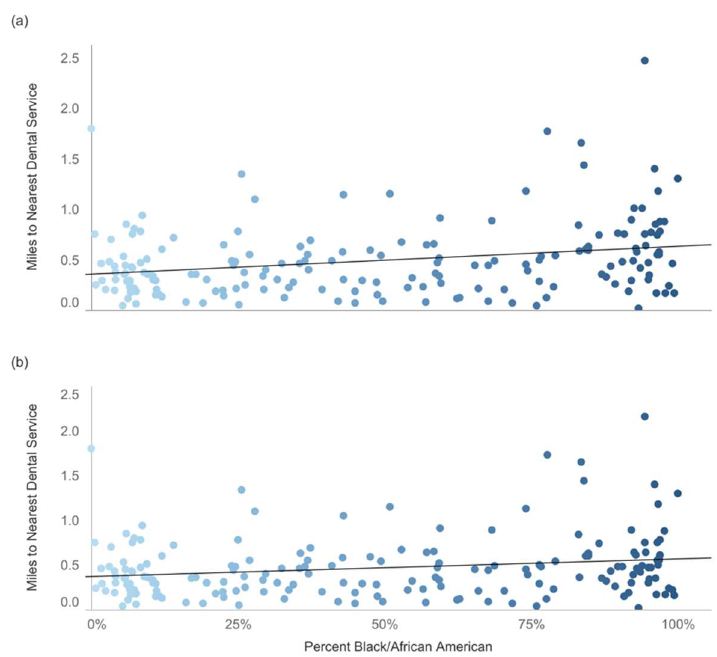
Figure 3. Correlation Between African American Population & Distance to Nearest Dental Service (by Census Tract). ( a ) Dental Services (R-squared = 0.07, p < 0.001); ( b ) Dental Services, including Federally Qualified Health Centers (R-squared = 0.04, p < 0.01)